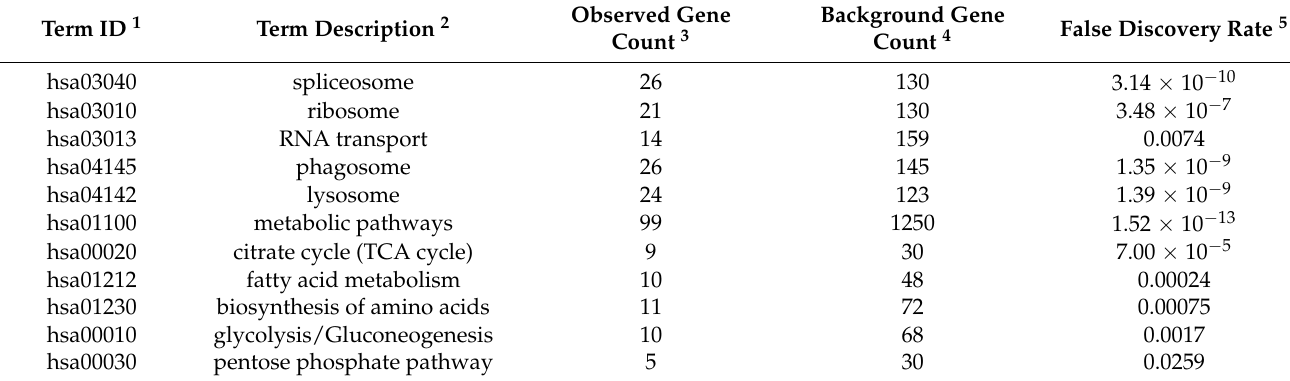
Table 4. Selected altered pathways in HF-MSS, based on KEGG enrichment